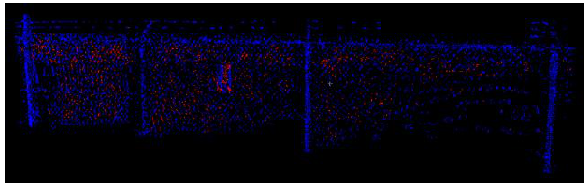
Figure 17. Segmentation results on fence obtained by PCA Tables 9-11 show results of the check point analysis. Achieving high precision